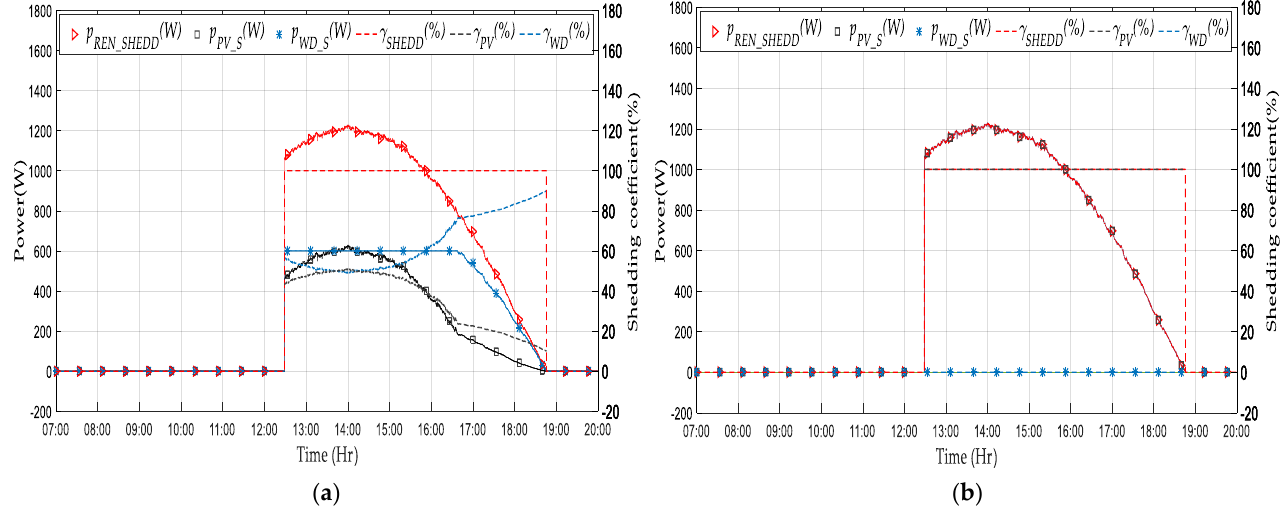
Figure 16. PV and SSWD shedding curves with optimization by applying the coefficient in the case of: ( a ) c PVS > c WDS ; ( b ) c PVS < c WDS . Table 6. Energy shedding calculation for coefficient in the case of optimization.